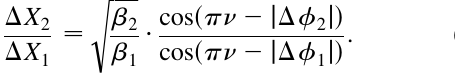
Table I. We can estimate the sum of the horizontal emit- tances from the coherent beam-beam tune shift. The calcu-